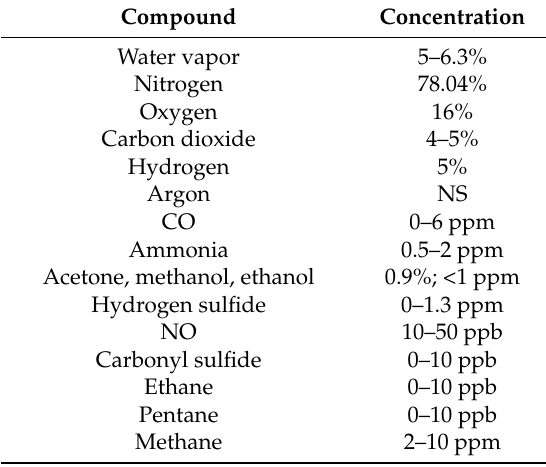
Table 3. Major volatile organic compounds present in the breath of healthy individuals